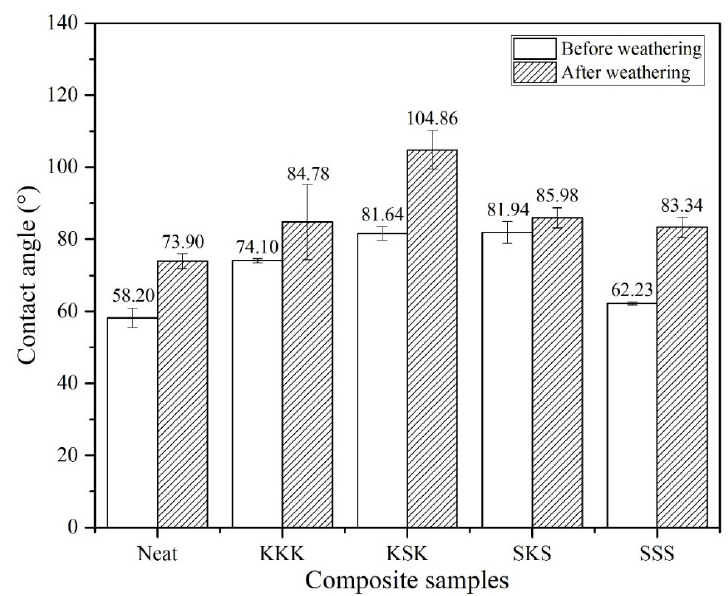
Figure 7. Comparison of contact angle measurements of before and after weathering composite samples.